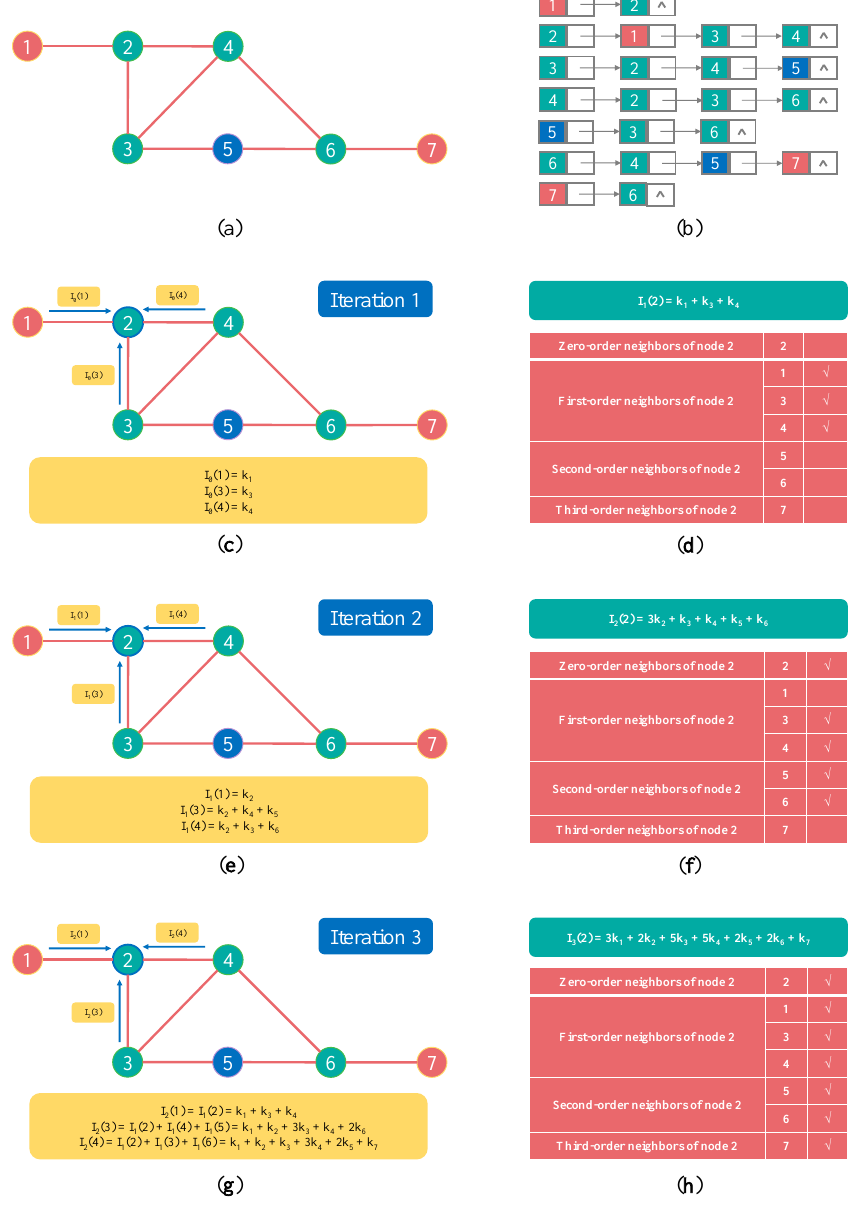
Figure 1. ( a ) An example network. ( b ) The adjacency list of the example network. ( c , e , g ) The process of each iteration of node 2. ( d , f , h ) The degree information of each order neighborhood collected by node 2 after each